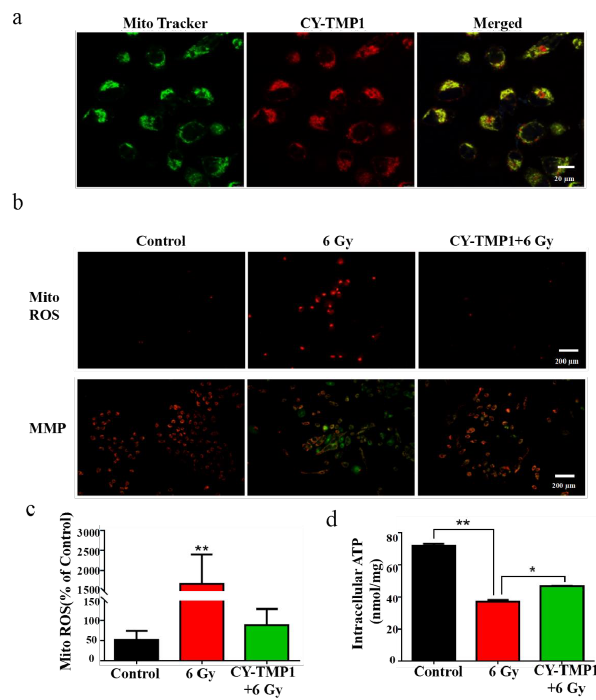
Figure 3. Mechanism study of CY-TMP1 with the radioprotection effect. ( a ) Subcellular localization of CY-TMP1 was detected with a mitochondria-specific green probe (Mito-Tracker); ( b ) Alterations in mitochondrial membrane potential (MMP) and mitochondrial ROS (Mito-ROS) were detected by a fluorescence microscope before and after 6 Gy X-ray radiation; ( c ) Quantitative analysis of mito- ROS based on the mean fluorescent intensity of per filed with Image J software ( n = 3, mean ±SD, ** p < 0.01, versus CY-TMP1+6 Gy group); ( d ) ATP was determined and compared with or without pretreatment of CY-TMP1, ( n = 3, mean ±SD, * p < 0.05, ** p < 0.01).